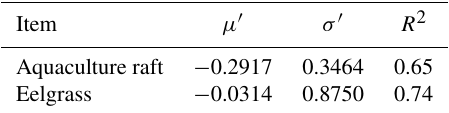
Table 2. Parameters to create the tsunami fragility